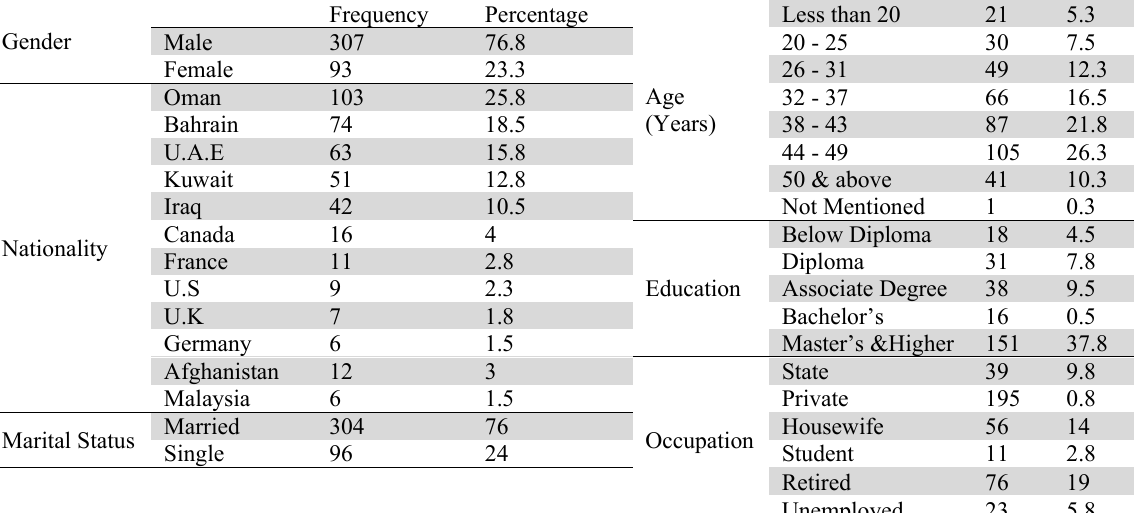
Descriptive analysis of sample population